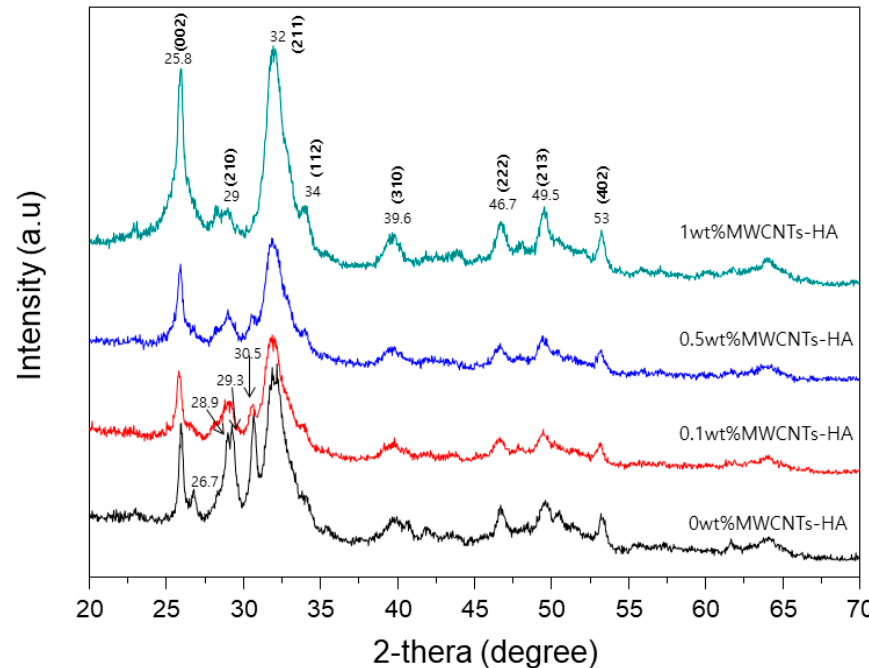
Figure 2. X-ray diffraction (XRD) pattern of MWCNTs-HA composites.